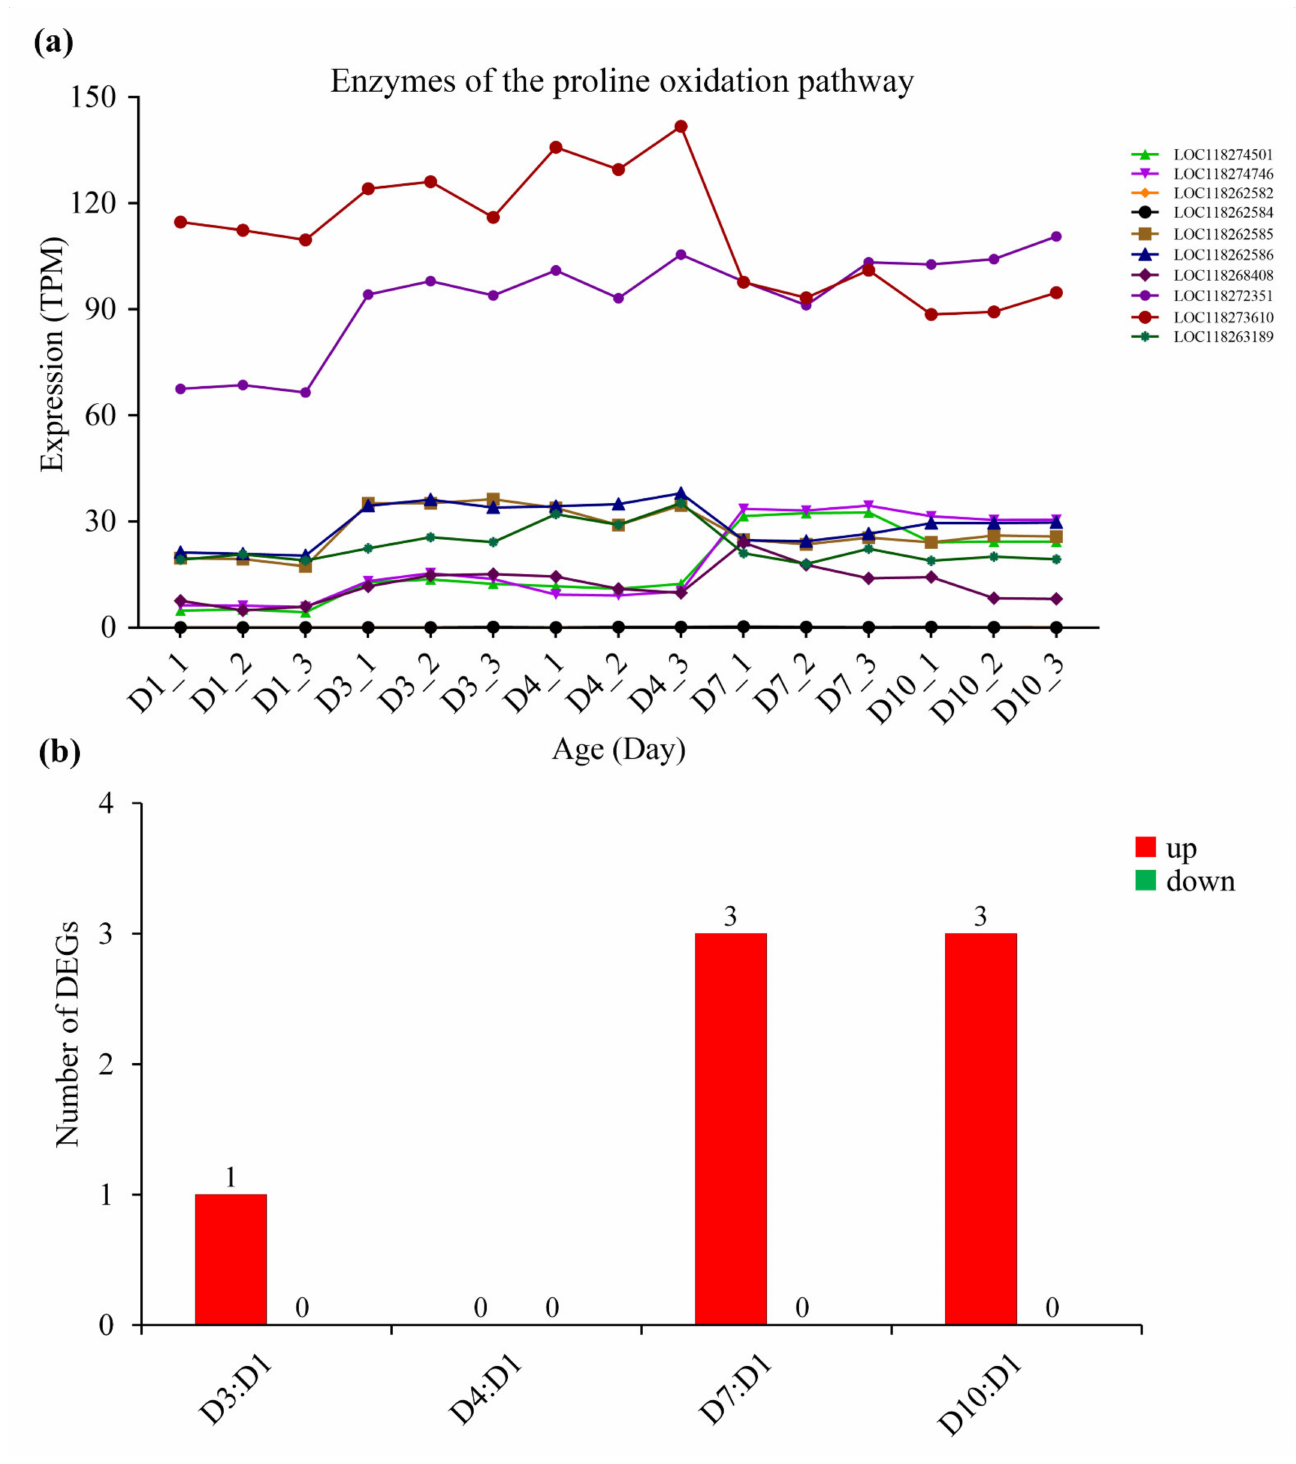
Figure 8. The expression of enzymes of the proline oxidation pathway in S. frugiperda females at different ages. ( a ) Changes in enzyme gene expression with age; ( b ) DEGs of D3:D1, D4:D1, D7:D1 and D10:D1 groups, wherein red columns represent upregulated DEGs and green columns represent downregulated